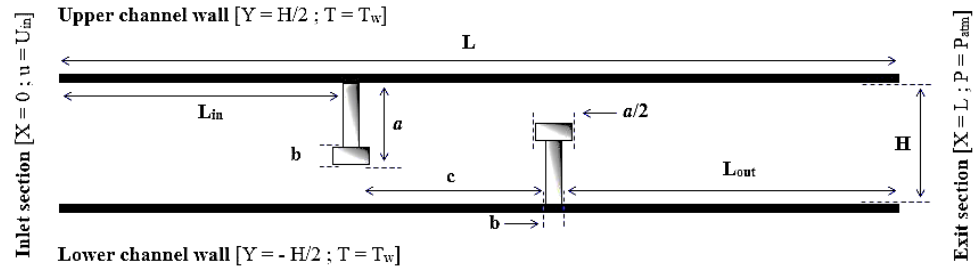
Figure 1. Channel heat exchanger with T-shaped baffles.